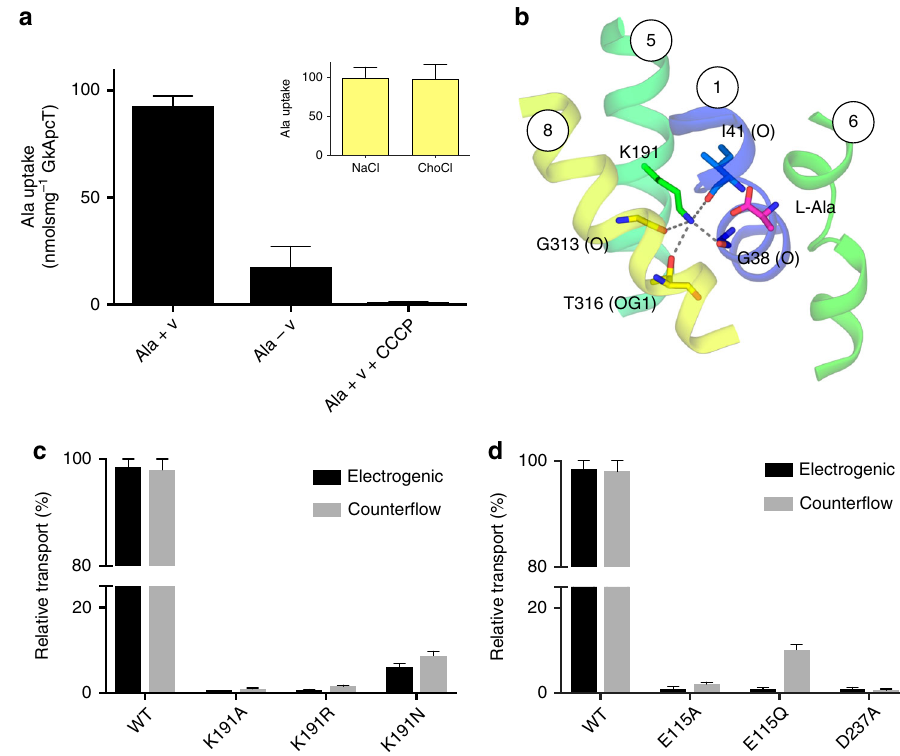
Fig. 3 Functional characterisation of proton coupling residues in GkApcT. a Proton-coupled uptake assays showing that accumulation of L -Ala is driven by an inwardly directed proton electrochemical gradient generated using valinomycin (+v) and an inwardly directed pH gradient ( − v). Transport was abolished in the presence of the proton ionophore CCCP. Inset — transport is independent of sodium. b View of Lys191 in the crystal structure, highlighting the interactions made to TMs 1 and 8. The bound L -Ala ligand is shown in magenta. c Mutational analysis of Lys191 using electrogenic and counter fl ow accumulation of 3 H L -Ala. d Mutational analysis of Glu115 and Asp237 using electrogenic and counter fl ow accumulation assays. n = 3 independent experiments, error bars